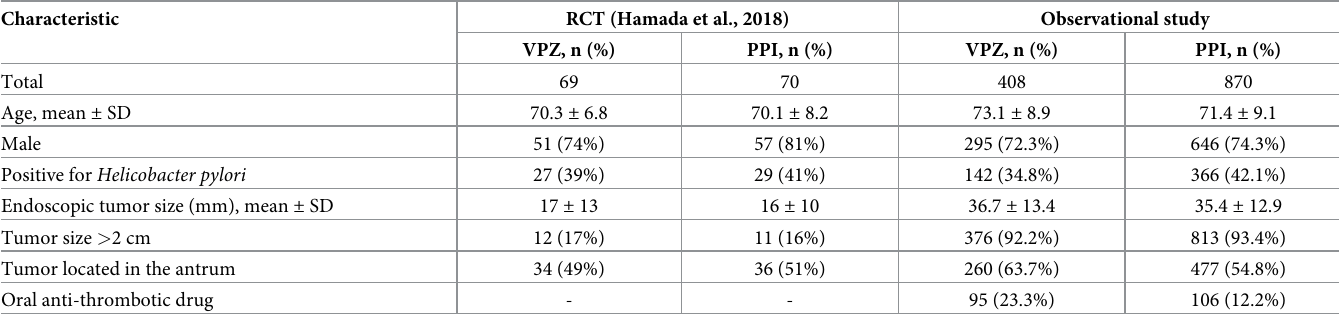
Table 2. Patient characteristics in the randomized clinical trial and observational study before propensity score matching. Characteristic RCT (Hamada et al., 2018)